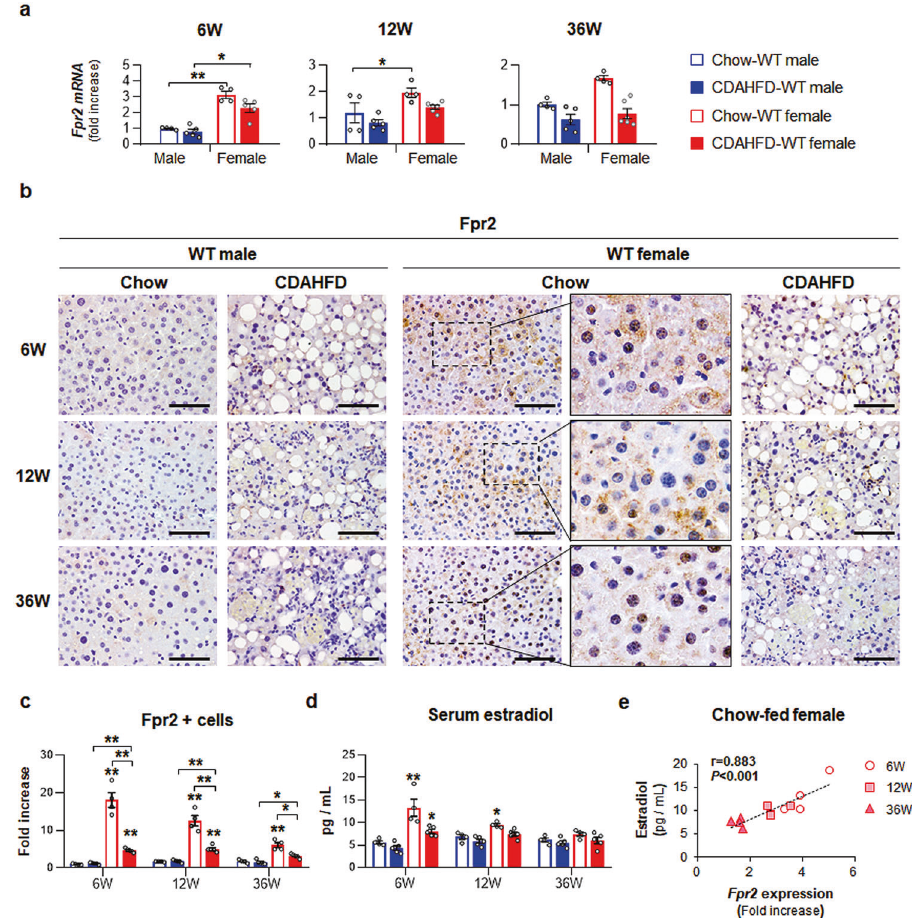
Fig. 3 Distinct Fpr2 expression in livers of female mice. a qRT-PCR for hepatic formyl peptide receptor 2 ( Fpr2 ) from WT male and female mice fed chow or CDAHFD. Data represent the mean ± S.E.M. ( n ≥ 4/group, * p < 0.05, ** p < 0.005 vs own control). b Representative Fpr2-immunostained liver images from these mice. Magni fi ed images of Chow-WT female in right panel are shown at X100 (Scale bar, 50 μ m). c Quantitative Fpr2-stained data from these mice. The numbers of Fpr2-positive hepatocytic cells were counted per fi led and divided by the number of total hepatocytes per fi eld. Data represent the mean ± S.E.M. ( n ≥ 4/group, * p < 0.05, ** p < 0.005 vs own control). d Amount of serum estradiol in these mice. Data represent the mean ± S.E.M. ( n ≥ 4/ group, * p < 0.05, ** p < 0.005 vs own control). e Pearson ’ s correlation between serum estradiol and Fpr2 expression of Chow-WT female mice ( n = 4/ group, r = 0.883, p < 0.001). Gray circles represent individual data points. See Supplementary Data for statistical